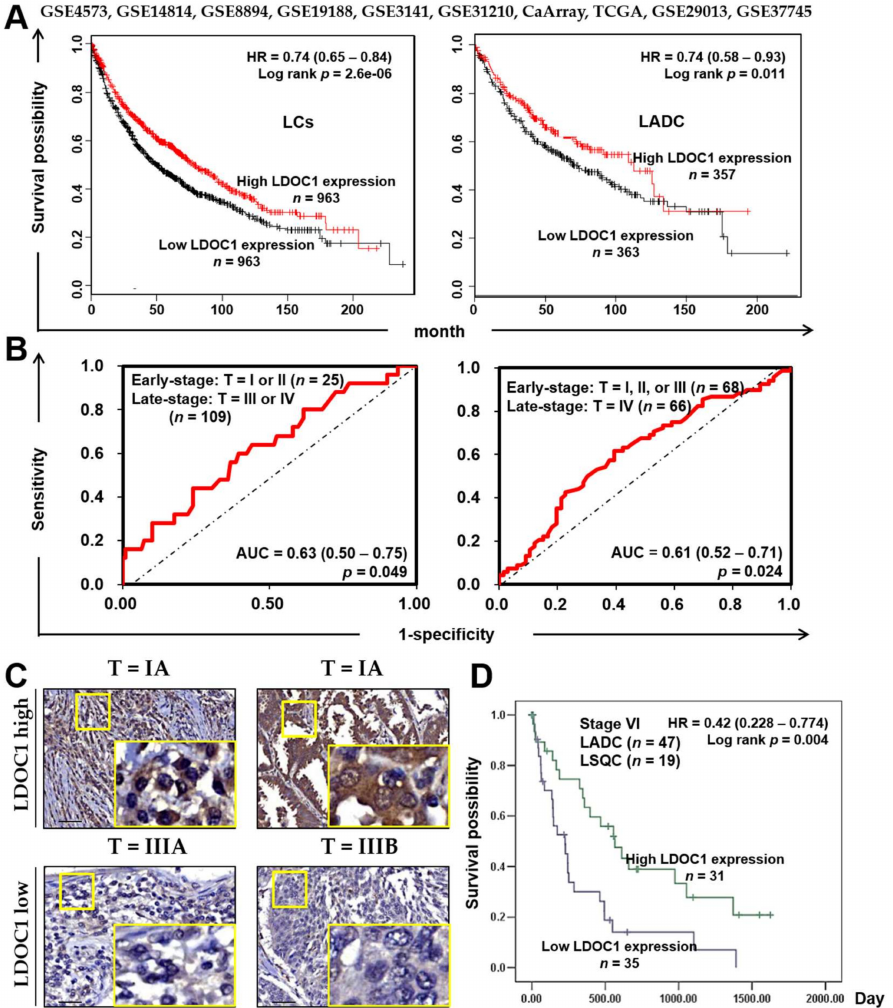
Figure 2. Prognosis analysis according to mRNA and protein expression of LDOC1 in lung cancer specimens. ( A ) Online Kaplan–Meier survival analysis (http://kmplot.com/analysis) of ten integrated published microarray datasets from lung cancer (LC, left) or LADC (right) specimens according to high or low LDOC1 mRNA expression levels (LC, p = 2.6 × 10 − 6 ; LADC, p = 0.011; log-rank test). ( B ) Receiver operating characteristic (ROC) curves for LDOC1 protein expression and